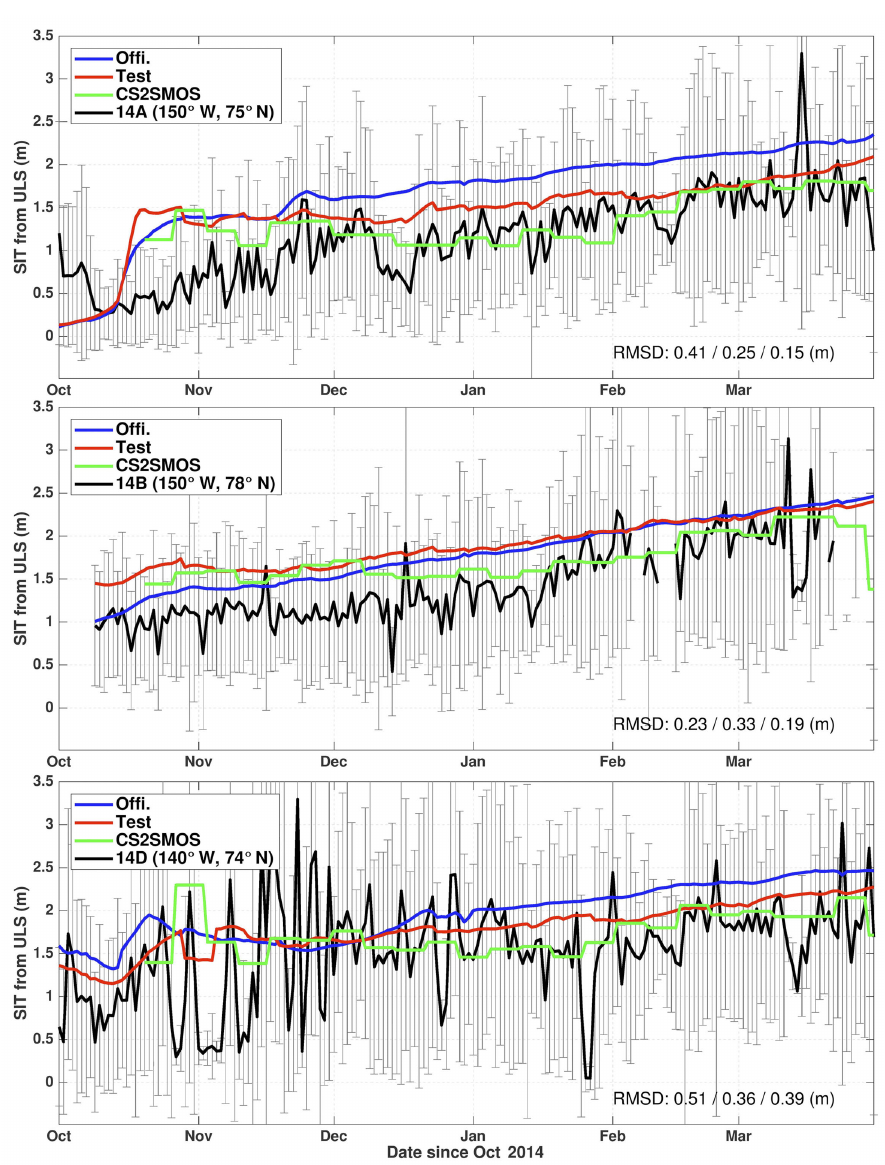
Figure 6. Daily series of SIT (black line) at the BGEP mooring (14A, 14B, and 14D) compared with the two model runs – Official (blue line) and Test (red line) – and the weekly observed by CS2SMOS (green line). The black line represents the daily average at the mooring location with the standard deviation shown as the error bar. The RMSDs of the Official run, Test run and CS2SMOS are respectively indicated on the bottom of each